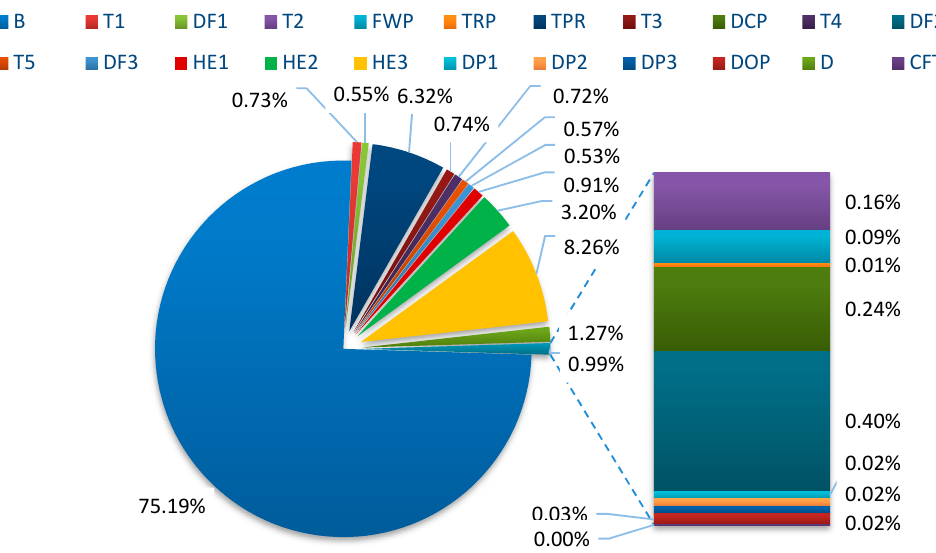
Figure 3. Percentage of each component’s energy loss of the total energy loss.